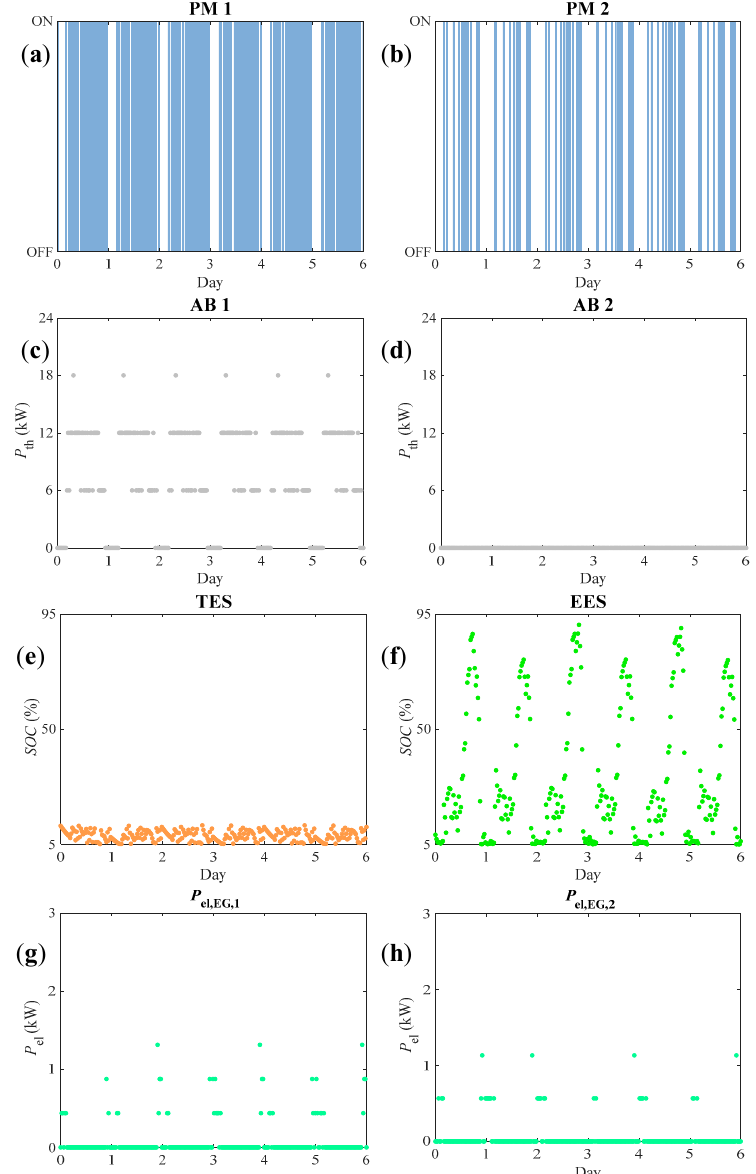
Figure 10. Best optimized strategy with “shared TES and EES”: ( a ) PM 1 switch-on time; ( b ) PM 2 switch-on time; ( c ) thermal power supplied by AB 1; ( d ) thermal power supplied by AB 2; ( e ) state of charge of the TES; ( f ) state of charge of the EES; ( g ) electric power taken from the electrical grid by user 1; ( h ) electric power taken from the electrical grid by user 2.